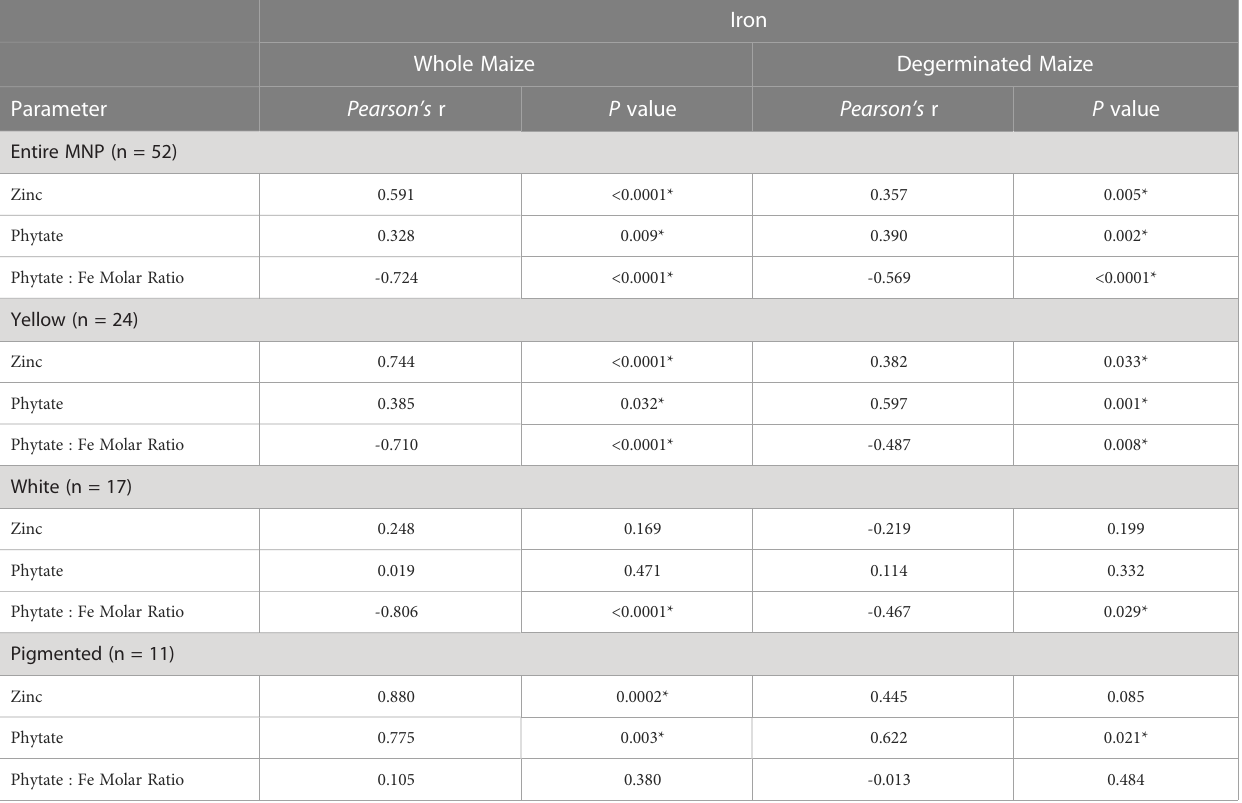
TABLE 5 Pearson correlations and associated P values between iron and the concentrations of zinc and phytate in the Maize Nutrition Panel (MNP) before and after removing the germ fraction (degerminated) 1 . Iron Whole Maize Degerminated Maize